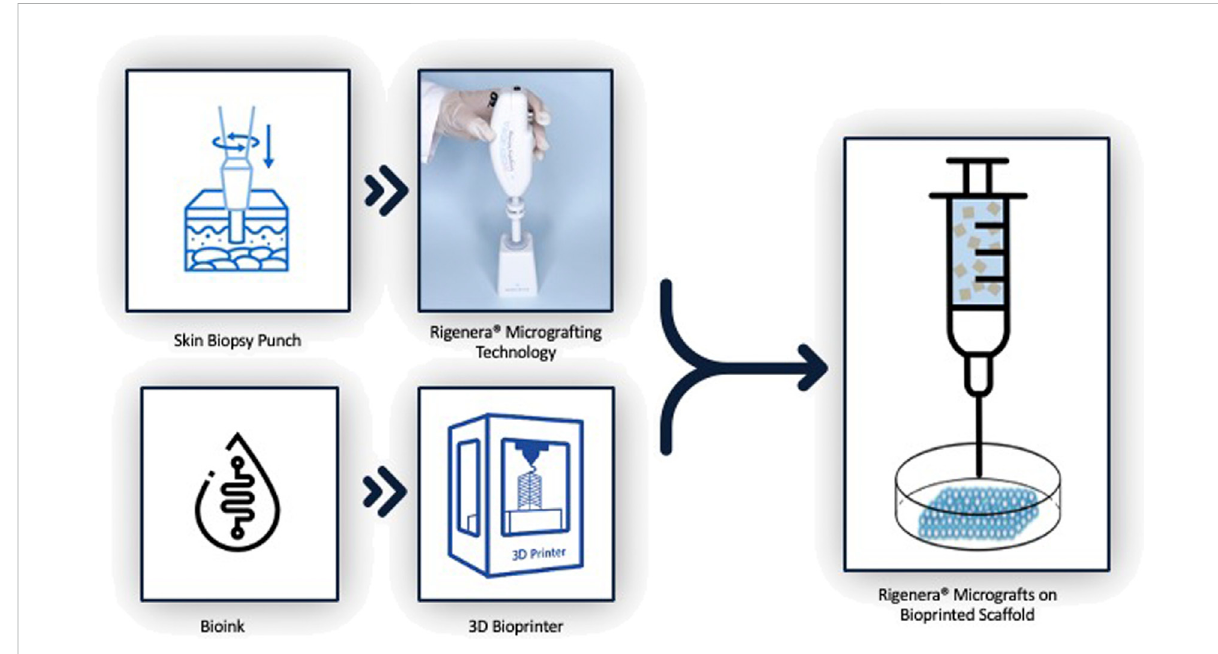
FIGURE 1 Process to obtain Rigenera ® micrografts on the bioprinted